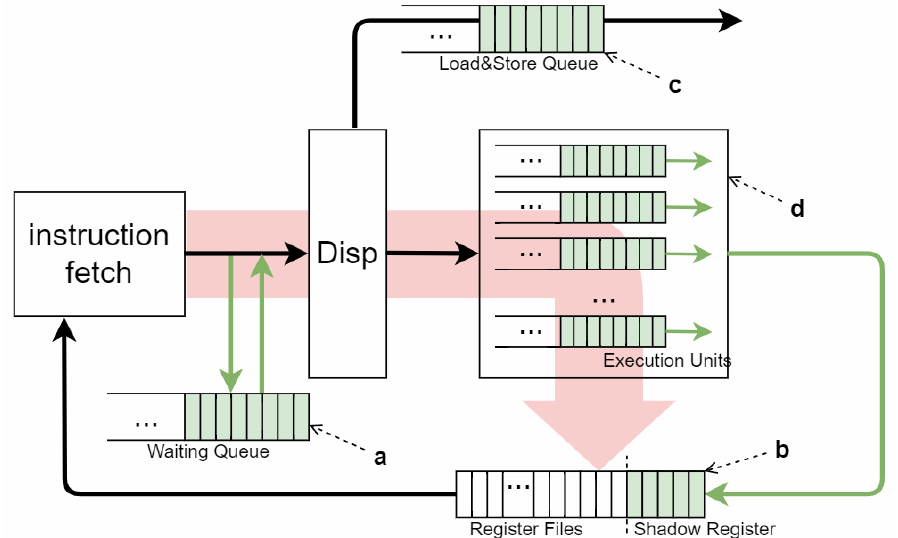
Figure 4. Schematic diagram of instruction flow. The green color marks the additionally added path for instructions, while the red color marks the main path. ( a ) Waiting queue. ( b ) Shadow register. ( c ) Load-Store queue. ( d ) Execution